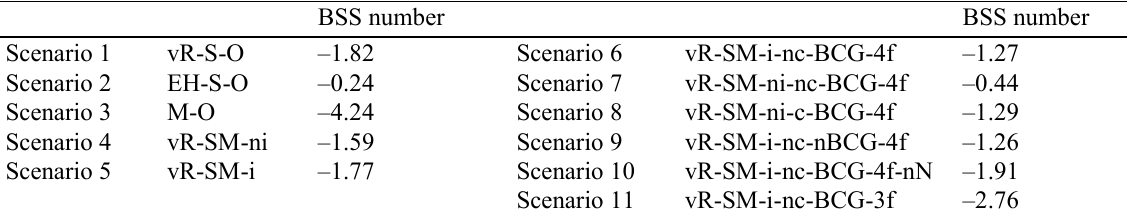
Table 4 BSS numbers for south branch according to scenarios 1 to